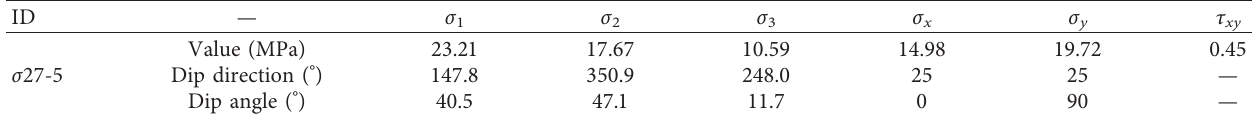
Figure 14: (a) 3D layout of Jinping I underground hydropower station caverns group. (b) The A-A ′ profile of the main powerhouse and transformer house. Table 5: In situ stress measuring points of underground powerhouse [65].